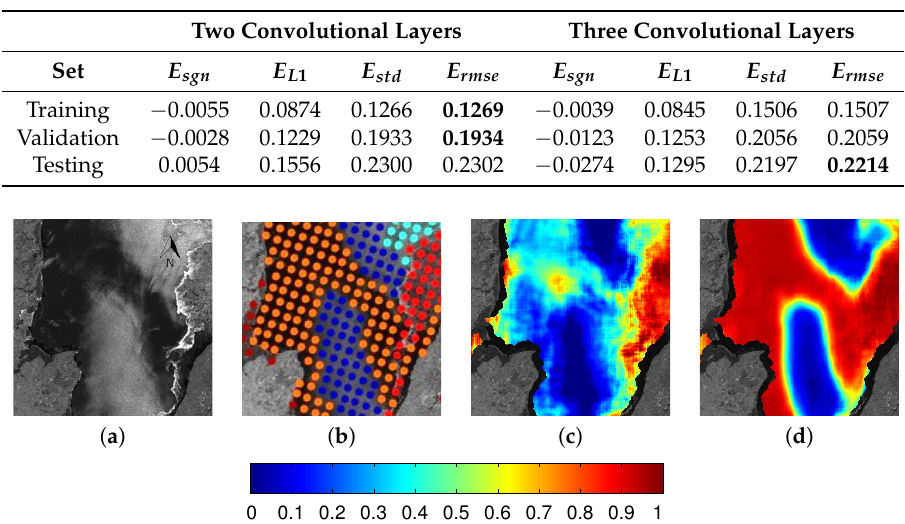
Table 6. Average error statistics for networks with two convolutional layers and three convolutional layers on the Gulf of Saint Lawrence dataset.